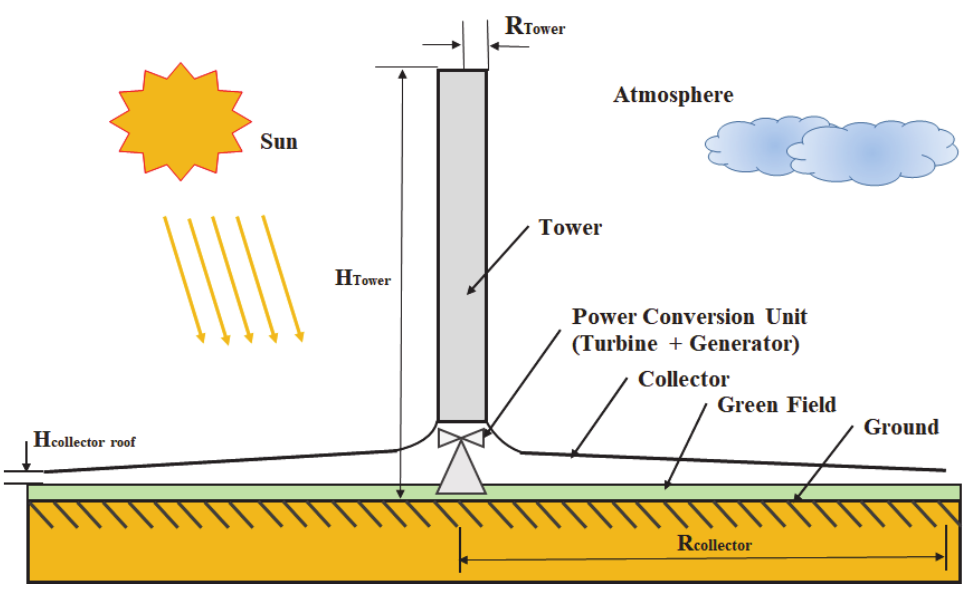
Figure 2. Schematic illustration of a SUTPP.